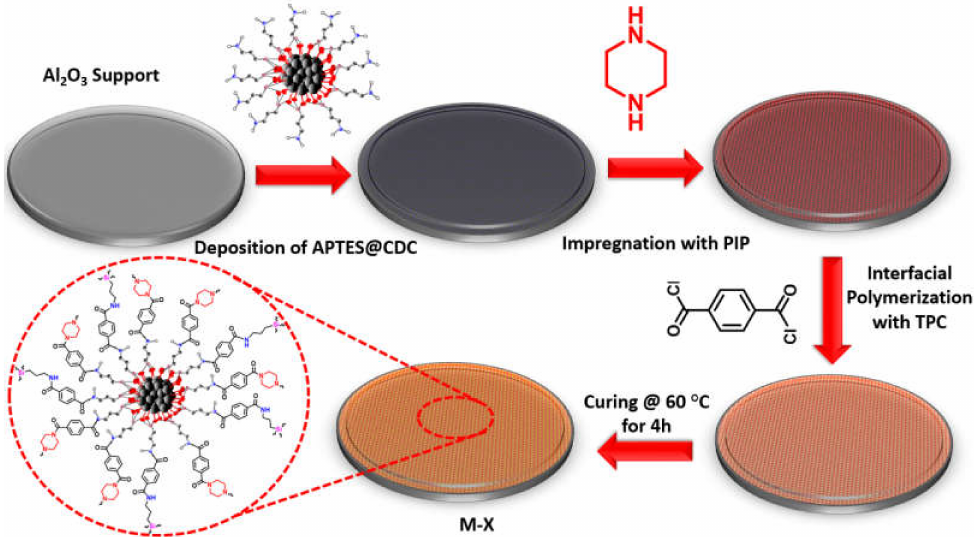
Figure 2. The steps involved in the fabrication of the M-X